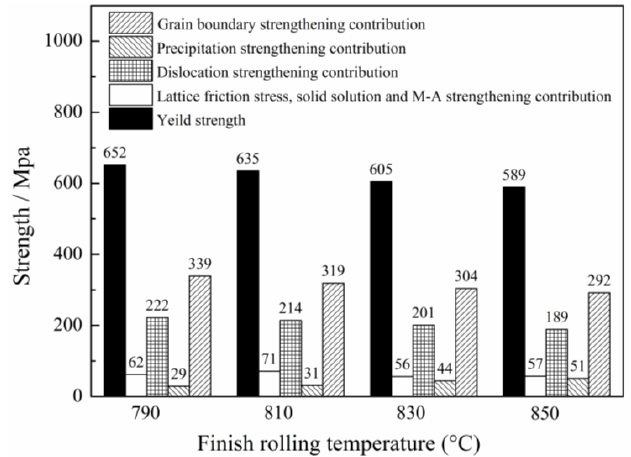
Figure 14. Results of contribution values of different kinds of strengthening mechanisms, as a function of the finish rolling temperature.